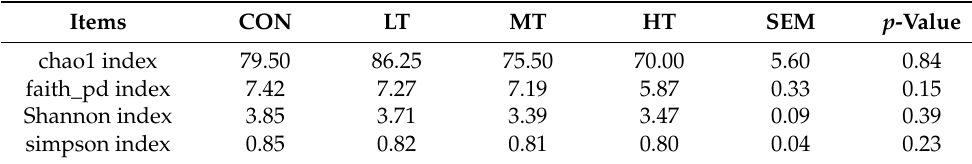
Table 4. Alpha diversity index of